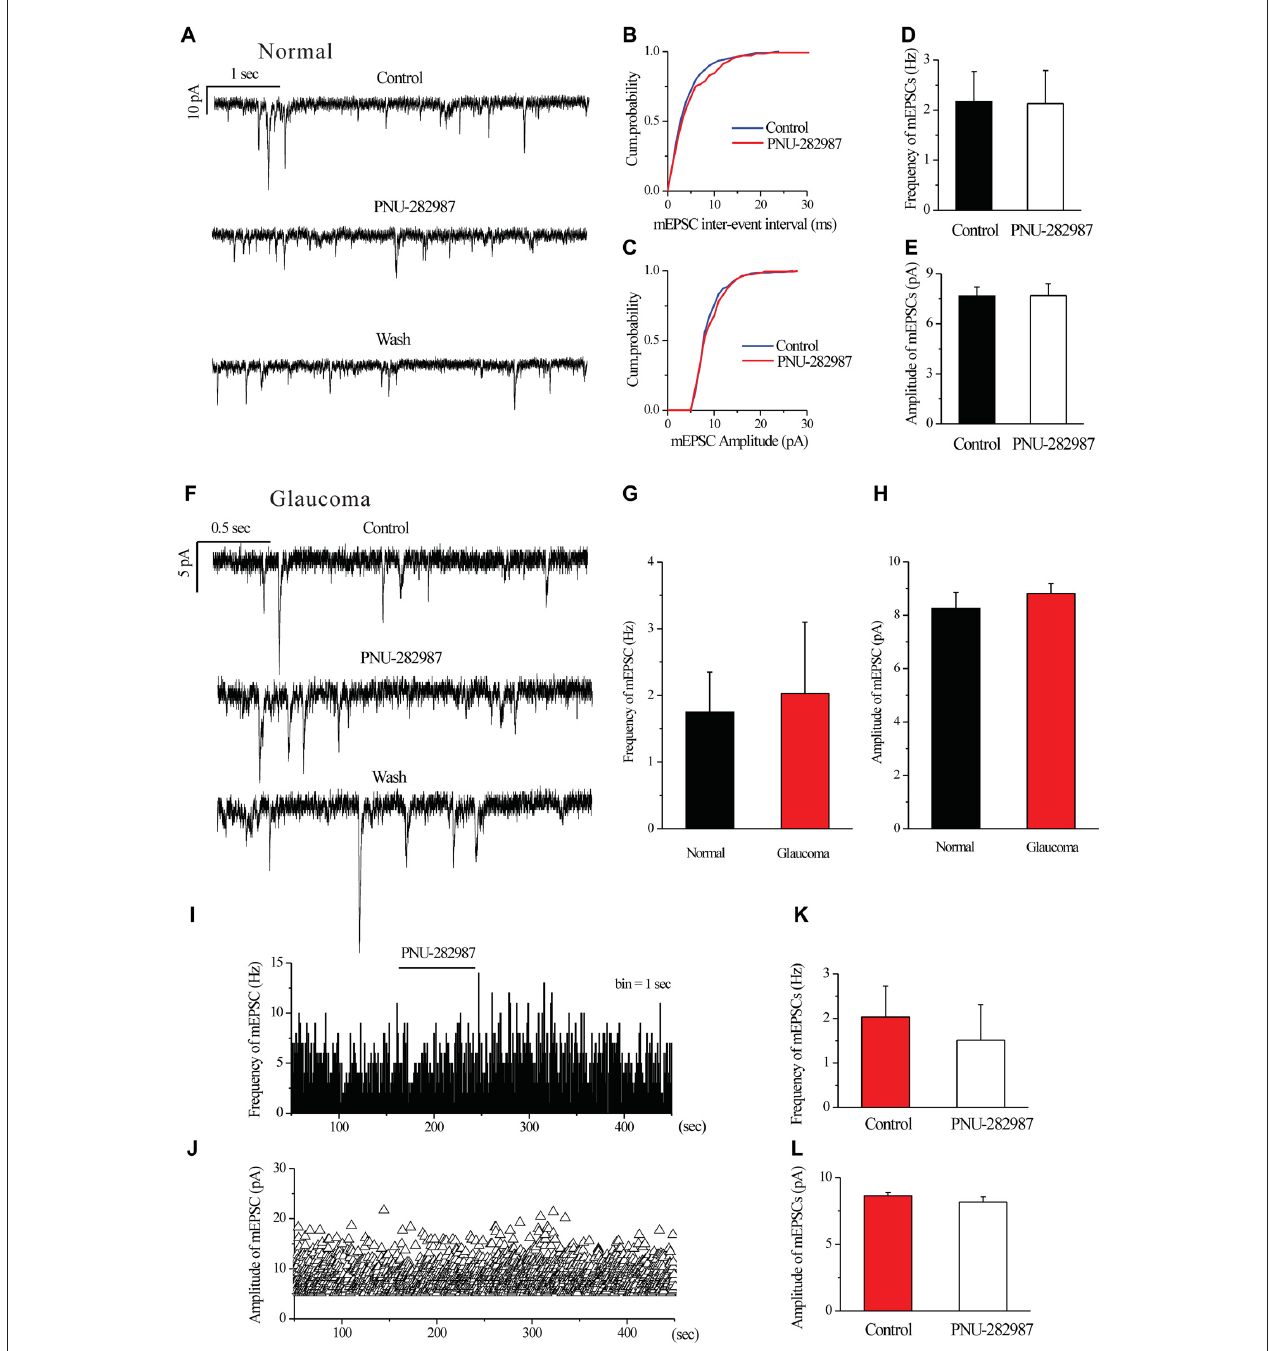
FIGURE 4 | Ocular hypertension or PNU-282987 did not cause a significant frequency or amplitude change in the miniature glutamatergic excitatory postsynaptic currents (mEPSCs) of RGCs. (A) Recording from a representative normal rat experiment during control conditions, during PNU-282987 application (10 µ M) and during recovery. Vertical calibration bar, 10 pA; horizontal calibration bar, 1 s. (B,C) Cumulative probability plots of mEPSC inter-event interval (B) and amplitude (C) before and during application of PNU-282987 ( n = 6, Kolmogorov–Smirnov test). (D,E) Summarized data of the frequency (D) and amplitude (E) of the mEPSCs in normal RGCs ( n = 6). (F) Recording from a representative glaucomatous rat experiment during control conditions, during PNU-282987 application (10 µ M) and during recovery. Vertical calibration bar, 5 pA; horizontal calibration bar, 0.5 s. (G,H) Bar graph illustrating the frequency (G) and peak amplitude (H) of the responses recorded from normal ( n = 4 in frequency; n = 6 in amplitude) and glaucomatous ( n = 5) RGCs. (I,J) Frequency (1-s bin) and amplitude histograms of the mEPSCs of the trace in (F) . (K,L) Summarized data of the frequency (K) and amplitude (L) of the mEPSC in glaucomatous RGCs ( n = 6). The results in (D,E,G,H,K,L) are expressed as the mean ± standard